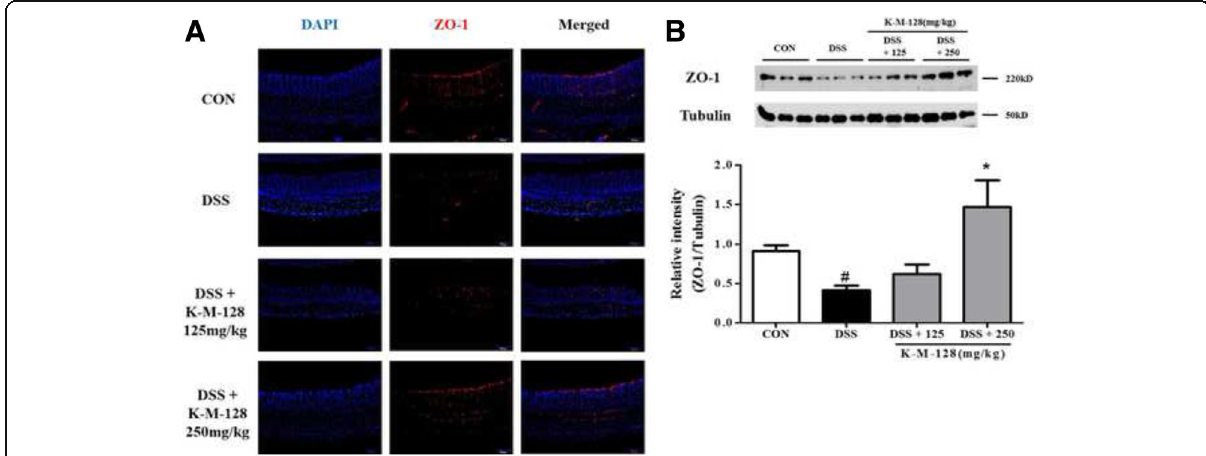
Fig. 4 The protective effect of KIOM-MA-128 against the degeneration of tight junctions. We stained the ZO-1 protein expressed in the intestinal crypts, and our formula repressed the degradation of ZO-1 after DSS treatment ( a ). In tissue lysates, our formula attenuated the down-regulation of ZO-1 after DSS treatment ( b ). These western blot data represent the mean ± SEM values of each mouse in the same group. # p < 0.05 versus the control group, * p < 0.05 versus the DSS-treated